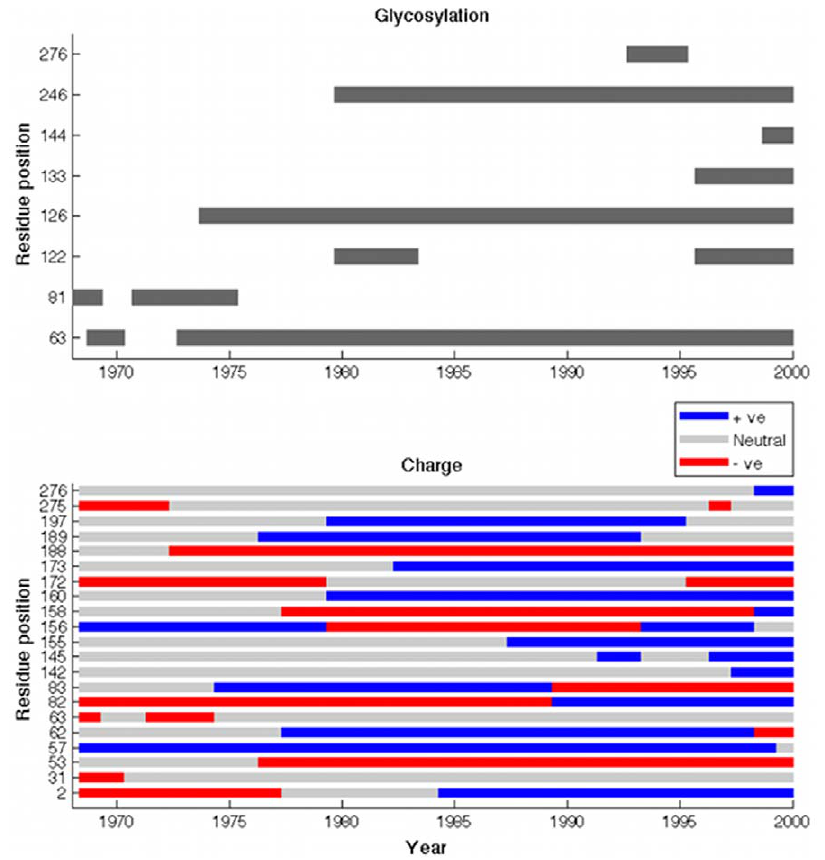
Figure 5. Estimated timing of major charge and glycosylation events. In the lower panel, grey bars denote the presence of an N- glycosylation sequon in at least 10% of sequences in a year. Note that where there are only few samples in a year, as depicted in Figure S1, estimates in both panels become less reliable.